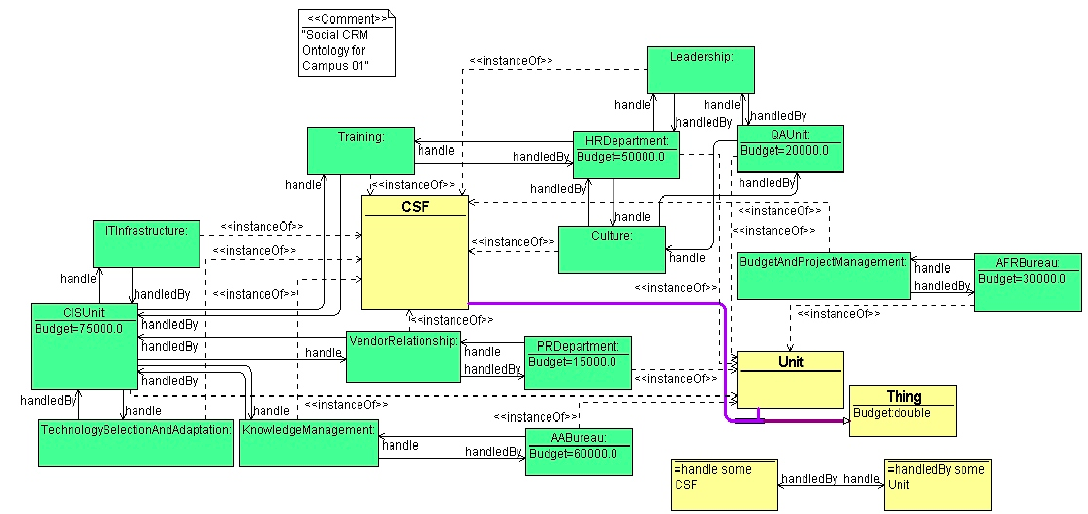
Figure 7. Social customer relationship management (CRM): the structure of classes and individuals in the OWL document.